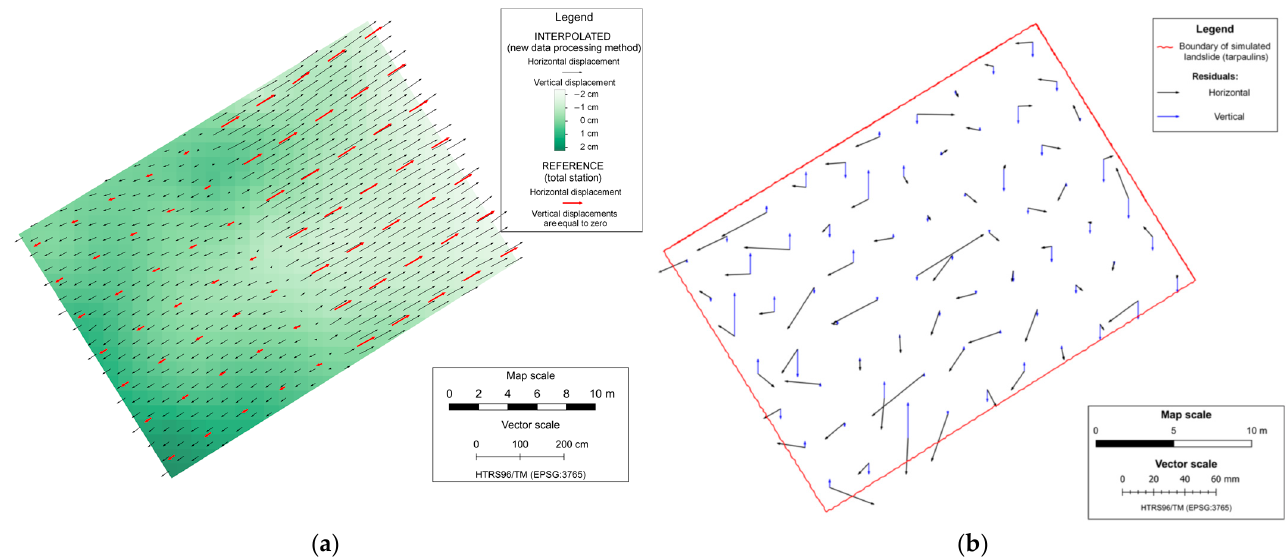
Figure 10. Displacement map of simulated landslide ( a ) and residuals in the first mission ( b ).